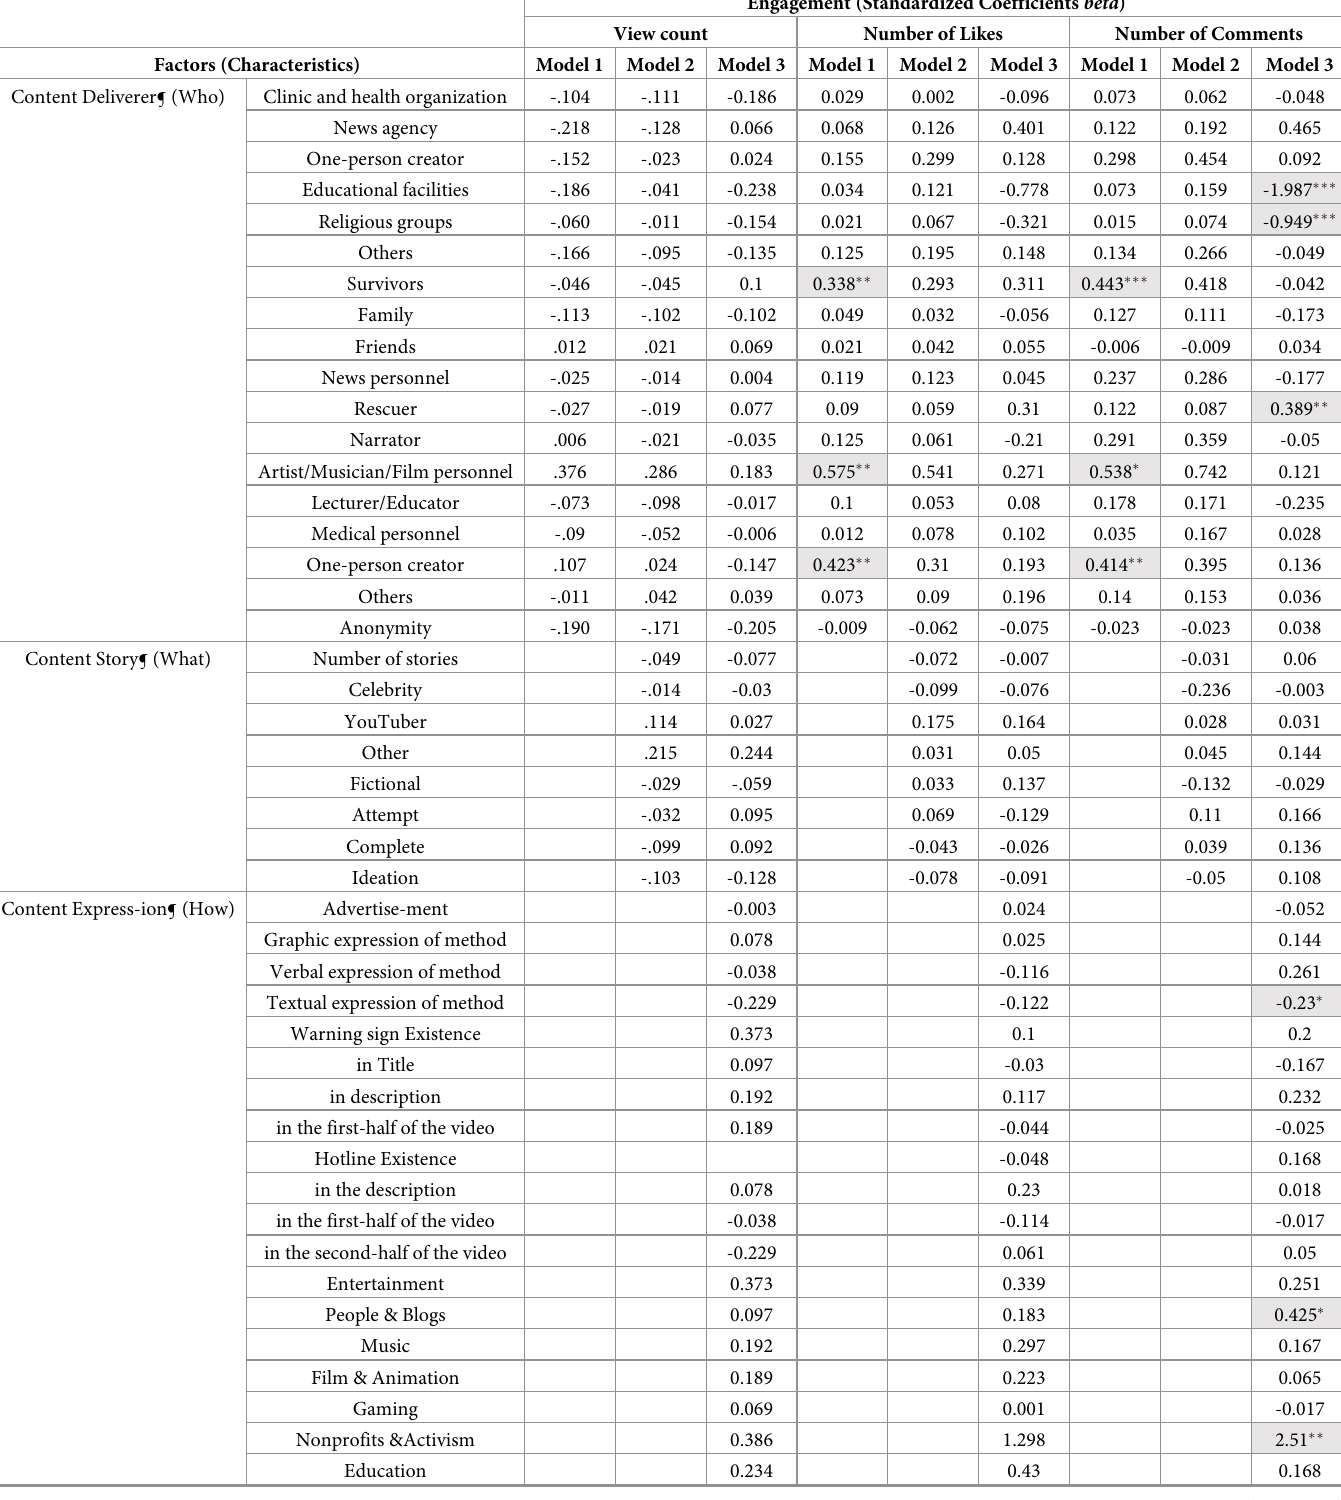
Table 4. Results for the hierarchical multiple regression analysis for